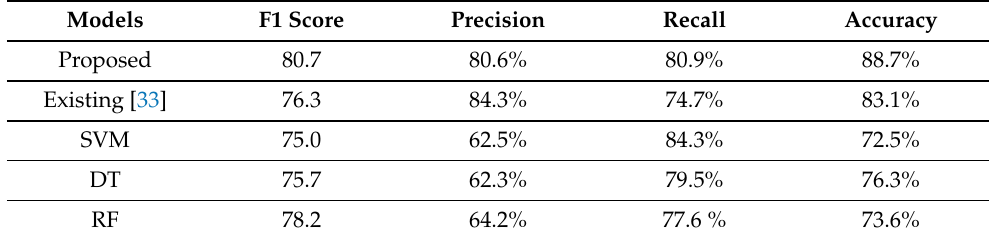
Table 4. Performance mapping of the executed models.